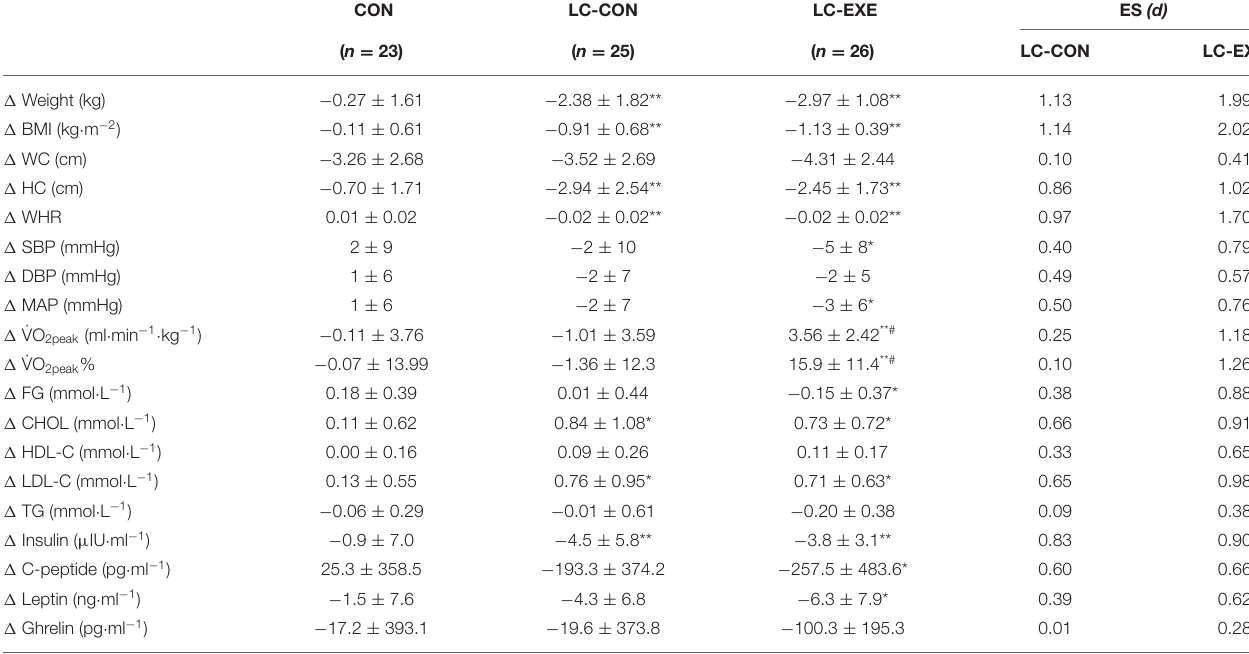
TABLE 2 | Changes in outcome variables after intervention.